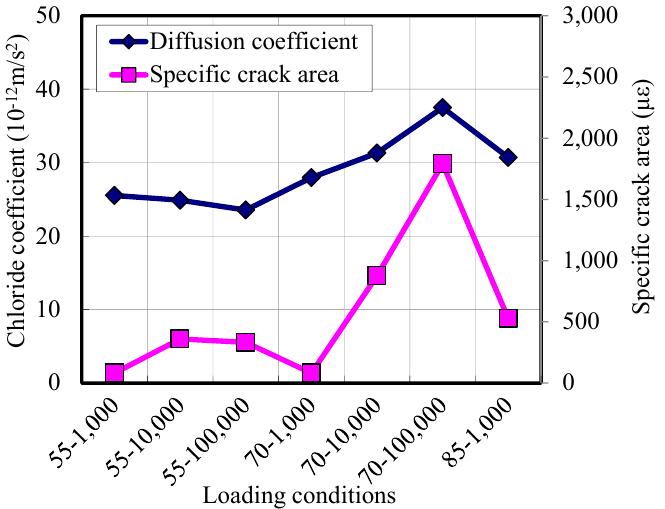
Figure 10. Chloride diffusion coefficients of damaged HPFRCC